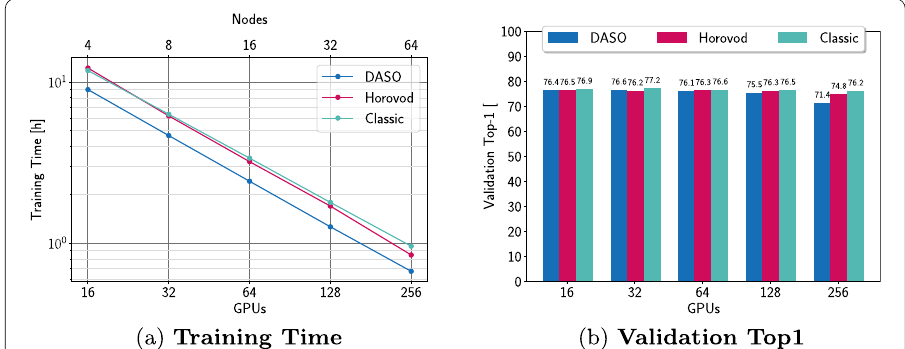
Fig. 6 ImageNet ResNet-50 training times and top-1 accuracy results on the ImageNet dataset when trained with DASO, Horovod, and the classic algorithm for increasing node counts. Each node has four